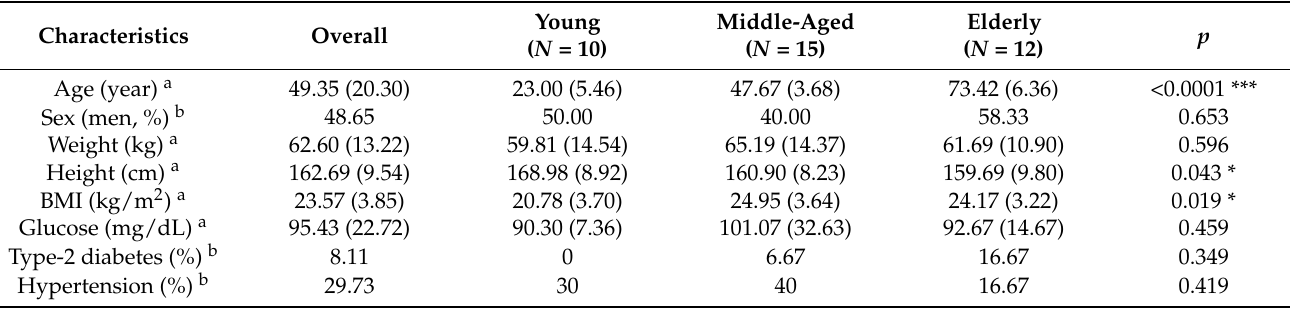
Table 1. Baseline characteristics in study